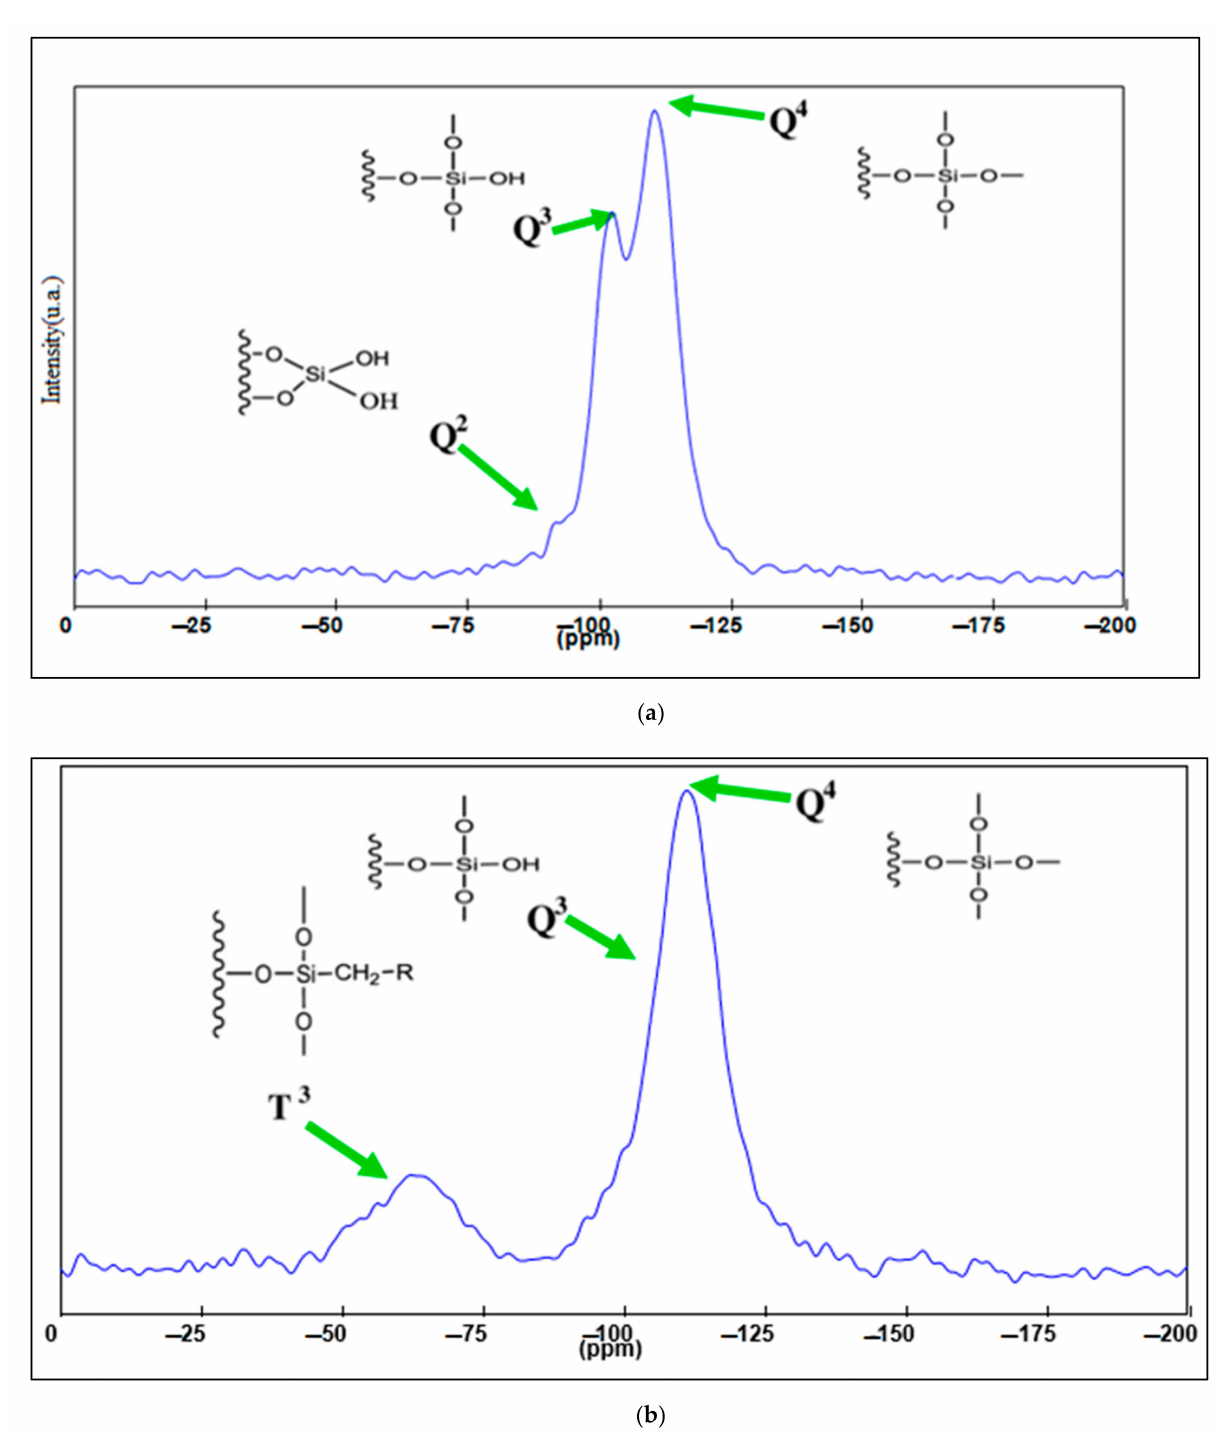
Figure 5. 29 Si MAS NMR spectrum (8 kHz rotation frequency) of non-functional mesoporous silica ( a ) and APS-grafted ( b )